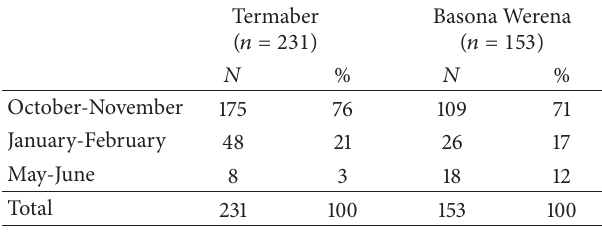
Table 5: Honey production period.